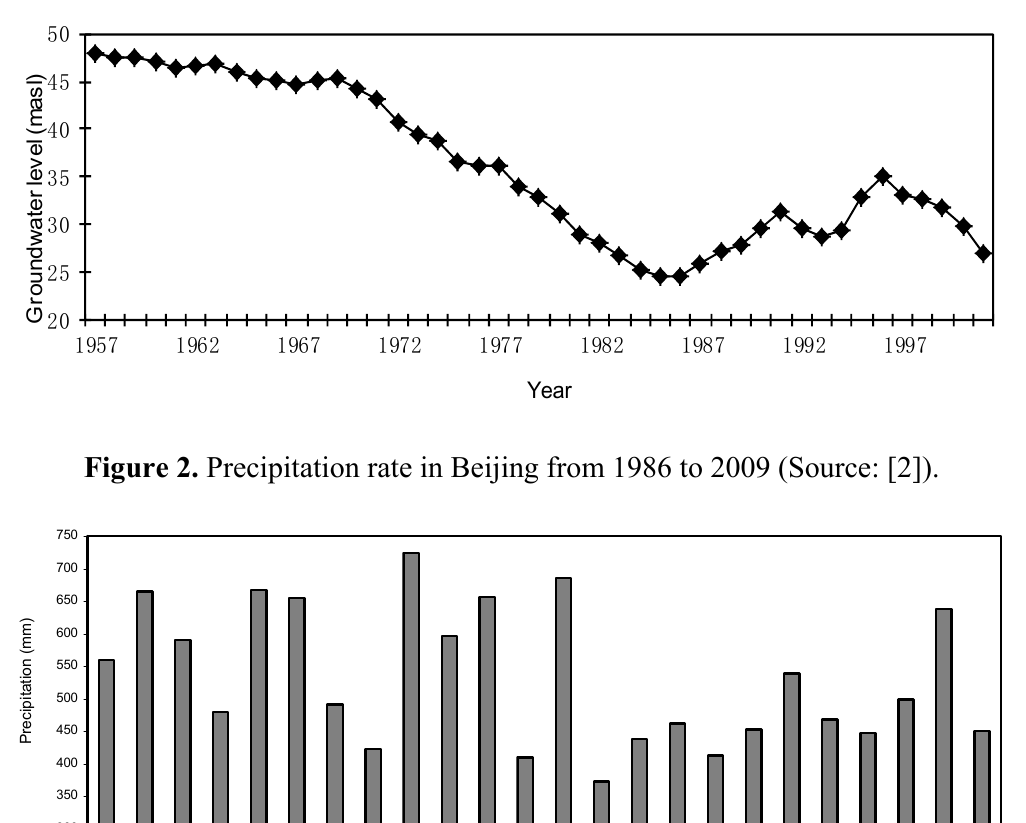
Figure 1. The change of groundwater water level in Beijing (Source: [7], masl means meters above sea level).